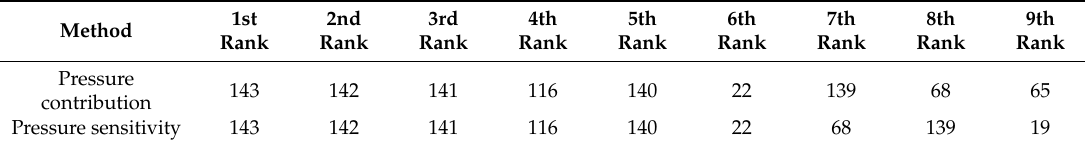
Table 10. Rank of monitoring location for pilot plant.